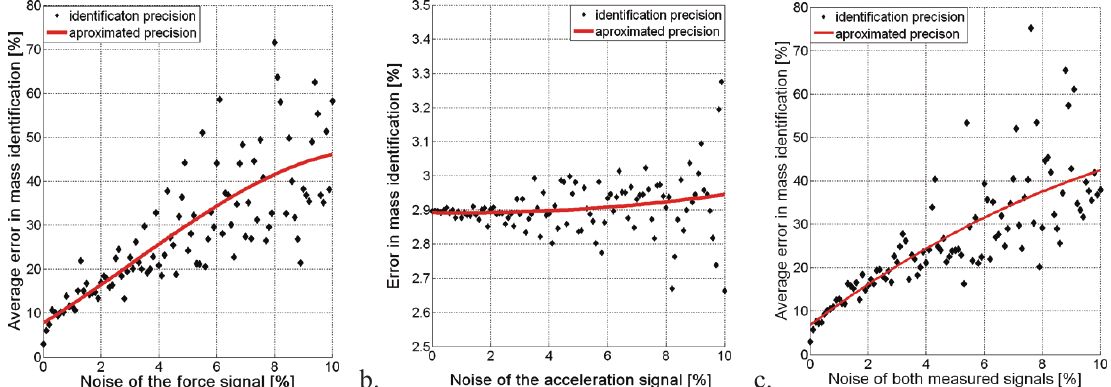
a. b. c. Fig. 13. Error of mass identi fi cation as a function of signal noise: a. force signal noise; b. acceleration signal noise; c. both signals noise. original signal. The results are presented in Fig. 13, where the force, acceleration and both quantities were